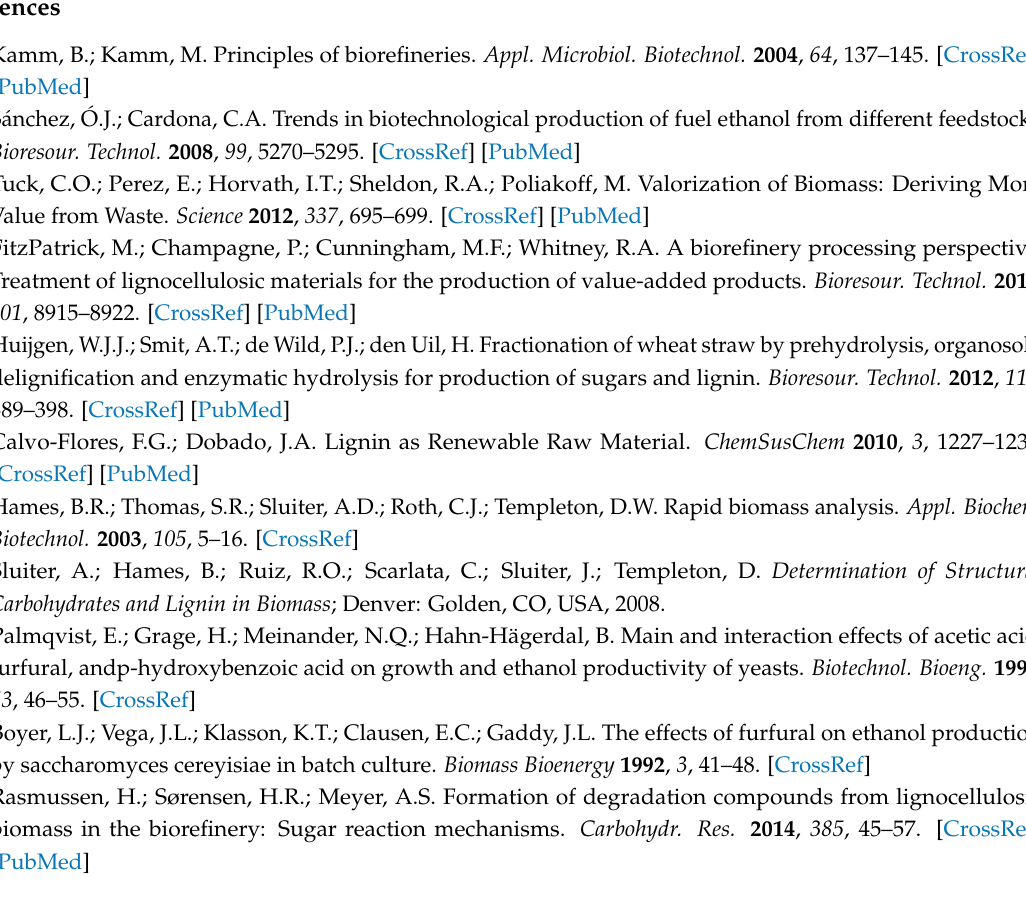
Table S1: Reference concentrations in data block 1, Table S2: Reference concentrations in data block 2, Table S3: Reference concentrations in data block 3, Table S4: Reference concentrations in data block 4, Table S5: Reference concentrations in data block 5, Table S6: Overview of datasets used for PLS modeling after different pre-processing methods of Block 1, Table S7: Overview of datasets used for chemometric modeling after different pre-processing methods of Block 2 to